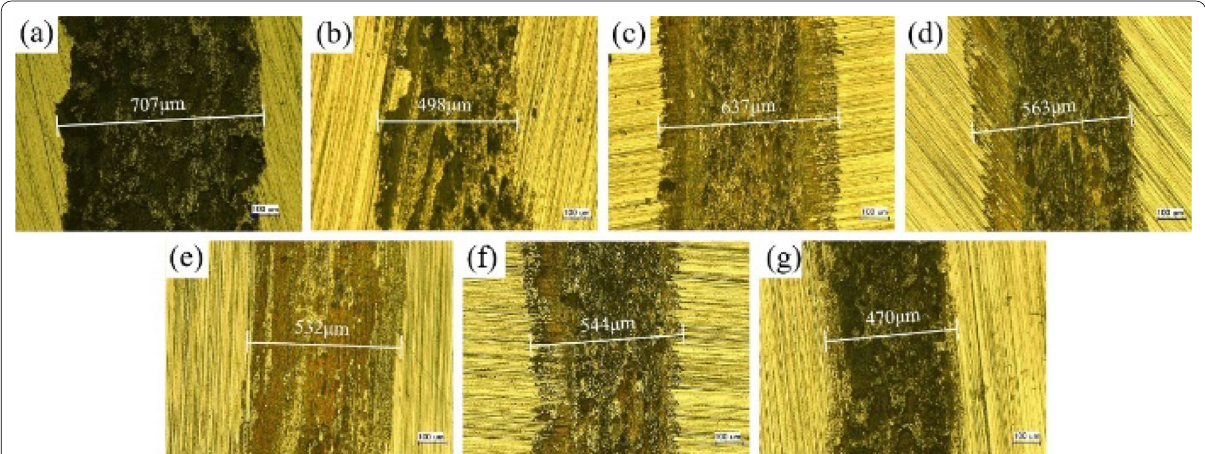
Figure 8 The surface morphologies of the wear scars of Nickel-based composite coatings: ( a ) 45 steel, ( b ) Ni60 coatings, ( c ) Ni60 coating ( d ) Ni60 coating 10 mesh, ( e ) Ni60 coating +